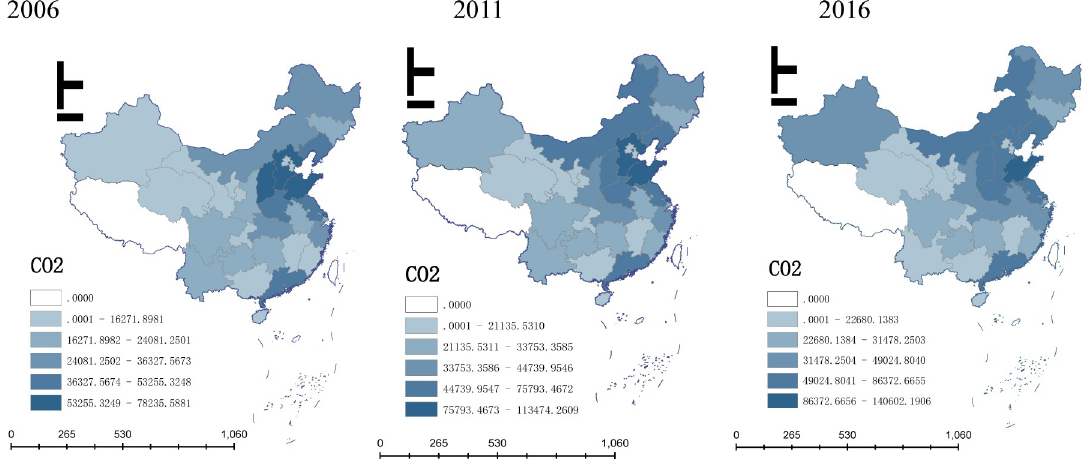
Fig 1. Spatial distribution diagram of CO 2 emissions in China.